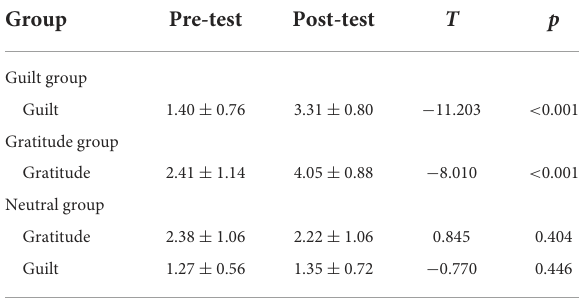
TABLE 1 Descriptive statistics of emotions ( M ± SD ) and paired sample t